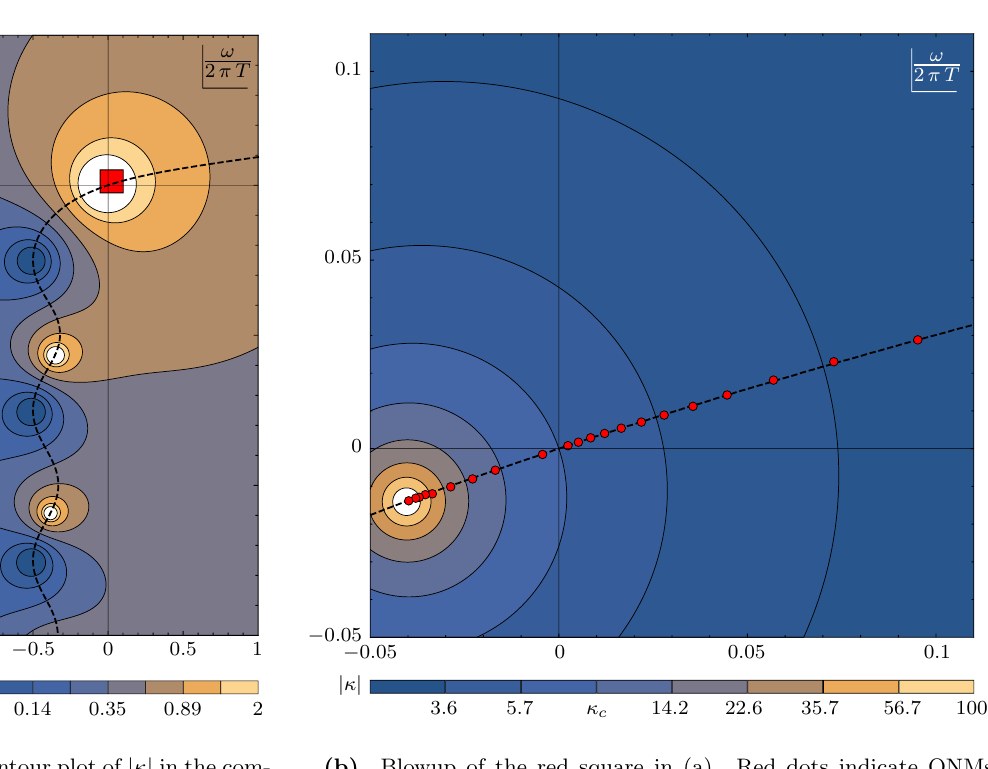
(a) Contour plot of j (cid:20) j in the com- (b) Blowup of the red square in (a). Red dots indicate QNMs plex frequency plane. White space extracted from numerical (cid:12)tting at di(cid:11)erent temperatures. White denotes cropping for values j (cid:20) j > 2. space denotes cropping for values j (cid:20) j > 100. Figure 7. Contour plot of j (cid:20) ( ! ) j over the complex ! -plane. A blow-up around the origin is shown in (b). Along the dashed curve (cid:20) ( ! ) is real. The contours denote constant values of j (cid:20) j , with the colour scale indicating the value. The contour (cid:20) ( ! ) = (cid:20) c intersects the dashed line at the origin in (b). The red dots are lowest lying QNM found from (cid:12)tting the time evolution of the scalar operator after the quench to the QNM behaviour de(cid:12)ned in eq.